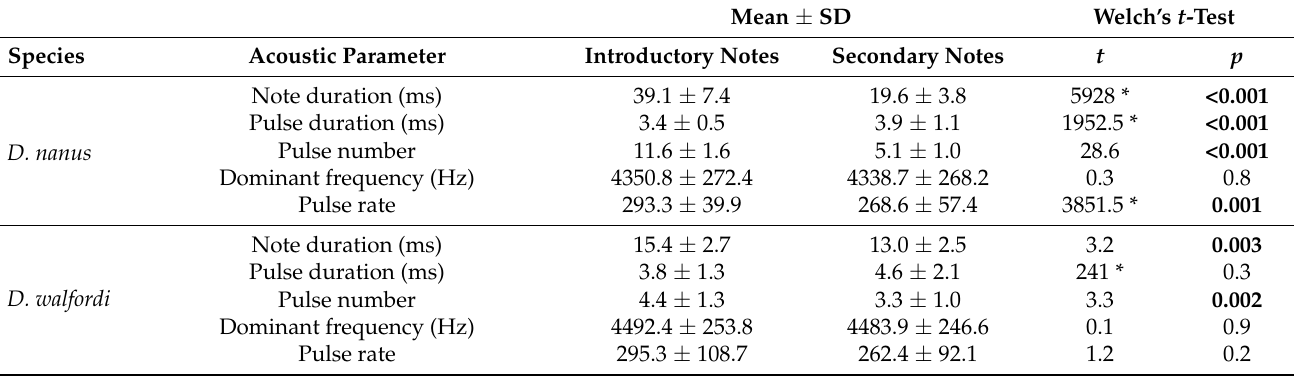
Table 2. Mean and standard deviation (SD) of each note’s acoustic variables and results from Welch’s t -tests comparing the introductory and secondary notes of the advertisement calls of each species. Bolded p -values correspond to significant results with α =